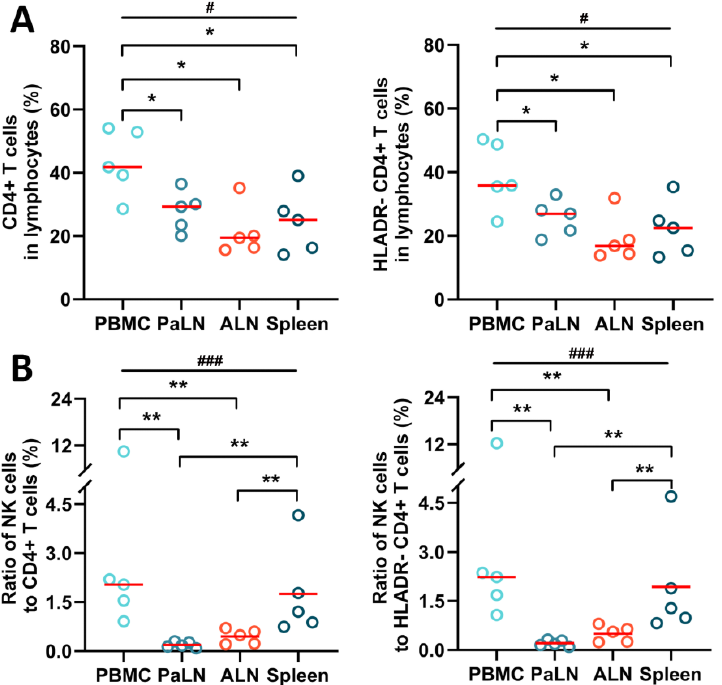
Figure 2. The ratio of NK cells to CD4 + T cells and HLADR − CD4 + T cells of SIV-infected macaques. ( A ) Levels of CD4 + T cells and HLADR − CD4 + T cells in single-cell suspension. ( B ) Ratio of NK cells to CD4 + T cells and HLADR − CD4 + T cells. Lines represent median values; little circles in different colors mean five SIV-infected macaques’ percentage levels in different groups. As the data did not obey a normal distribution, after comparing multiple group differences using the Kruskal–Wallis test, the Mann–Whitney U test was performed to compare differences between the two groups. “#” indicates significant differences using the Kruskal – Wallis test (#, p < 0.05; ##, p < 0.01, ###, p < 0.001). “*” indicates significant differences by Mann–Whitney U test (*, p < 0.05; **, p < 0.01). PBMC—peripheral blood mononuclear cell; PaLN — paracolonic lymph node; ALN — axillary lymph node.